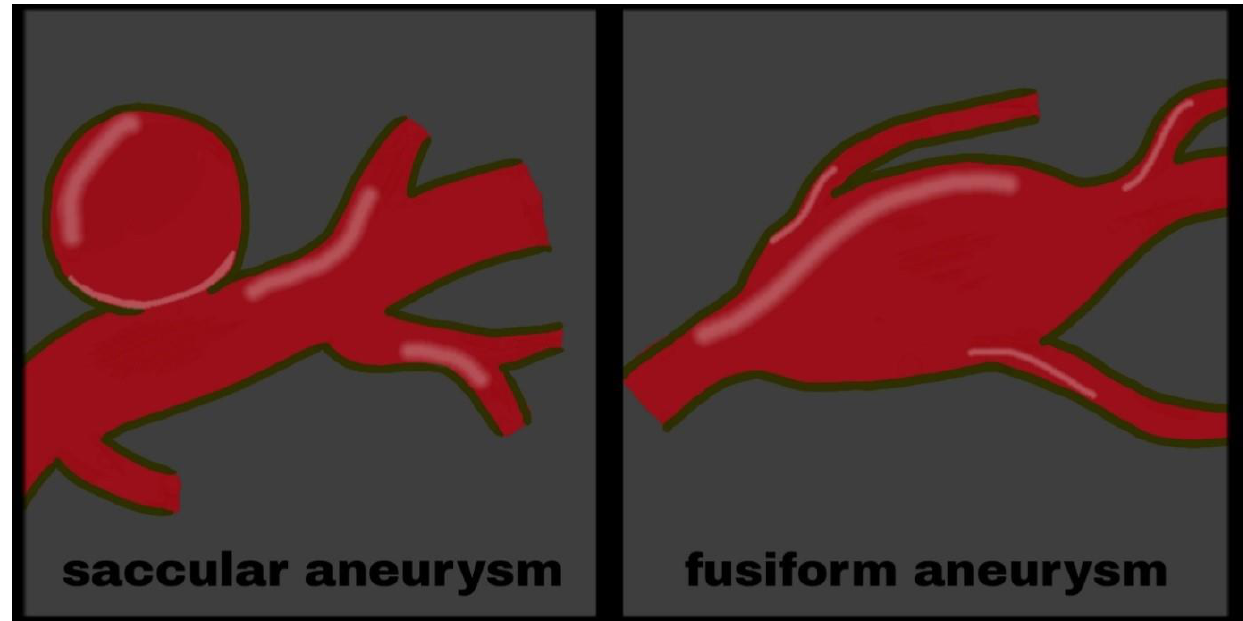
Figure 3. Aneurysms. Figure 3.